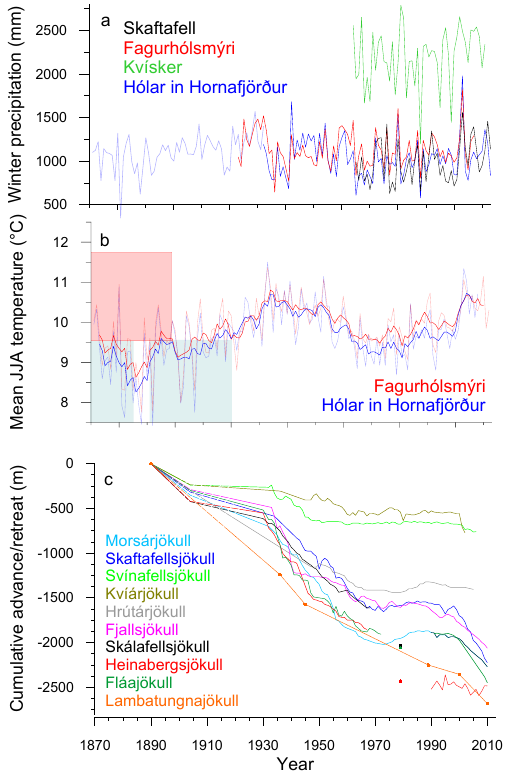
Figure 2. (a) Winter precipitation (October–April in mm) at Skaftafell (black), Fagurhólsmýri (red), Kvísker (green) and Hólar in Hornafjörður (blue), see Fig. 1a for the location of stations. Reconstructed precipitation indicated with a light blue line (from Aðalgeirsdóttir et al., 2011). (b) Mean summer (JJA) temperature at Fagurhólsmýri (red) and Höfn in Hornafjörður (blue) and 5 years running average. Light blue and light red boxes indicate the time period of reconstructed temperature (from Aðalgeirsdóttir et al., 2011). (c) Cumulative frontal variations of the southeast outlet glaciers relative to the ∼ 1890 terminus position determined from the terminal LIA moraines (Hannesdóttir et al., 2014). The retreat until 1932, when measurements of volunteers of the Icelandic Glaciological Society started, is indicated by broken lines; the position in 1904 is known from the maps of the Danish General Staff; note that a linear recession is not expected in ∼ 1890–1904 or 1904–1932. Annual measurements are shown with a solid line (http://spordakost.jorfi.is). Skálafellsjökull, Heinabergsjökull and Fláajökull were not measured in the 1970s and 1980s, but their terminus position in 1979 is determined from aerial images of the National Land Survey of Iceland (indicated by dots). The terminus of Lambatungnajökull (orange line) has not been measured, but its recession is retrieved from maps, aerial photographs and satellite